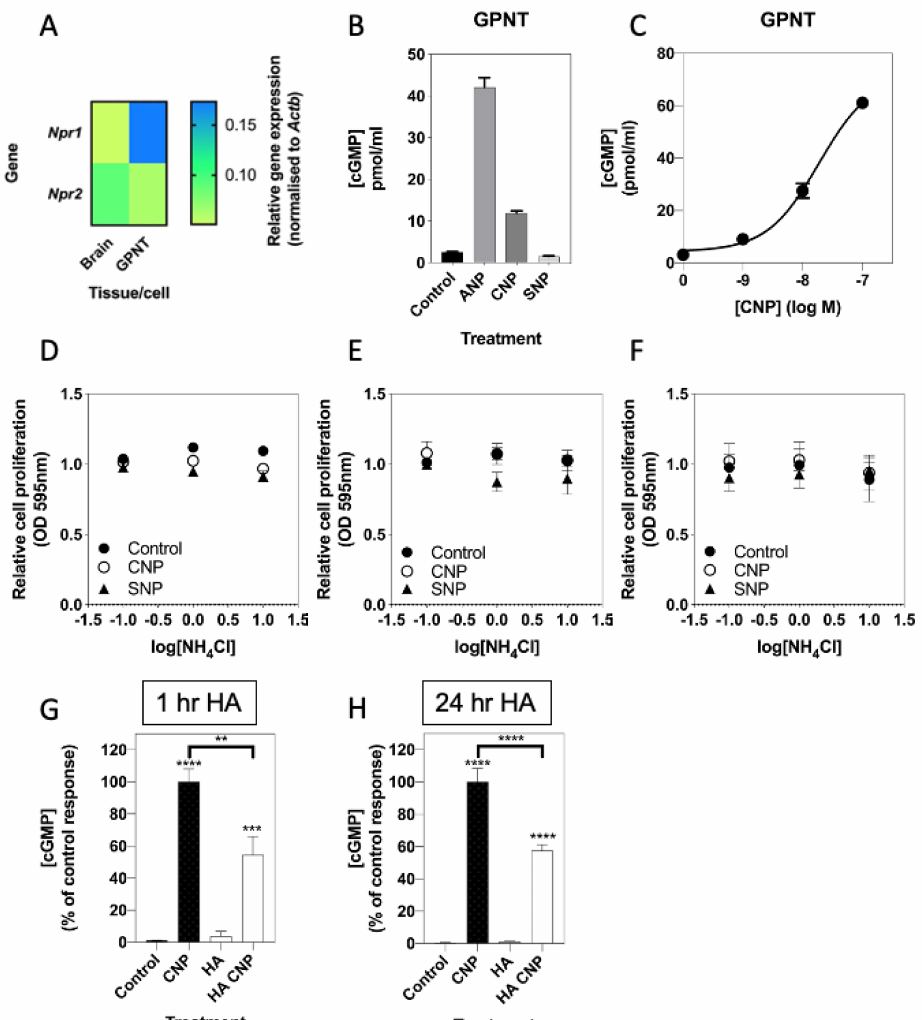
Figure 8. Effects of hyperammonaemia on the natriuretic peptide system in rat GPNT brain endothelial cells. ( A ) Multiplex RT-qPCR was performed on RNA extracted from rat brain tissue or GPNT cells. The data shown are mean relative gene expression, normalized to Actb , of 2 individual RNA extractions. ( B ) Total cGMP accumulation in GPNT cells treated with 0 or 100 nM ANP, CNP or 1 mM SNP for 1 h in physiological saline solution containing 1 mM IBMX, before assay. Data shown are means ± SEM of triplicate treatments. ( C ) Concentration-dependent effects of CNP on cGMP accumulation in C6 cells. Cells were treated with the indicated concentrations of CNP in PSS containing 1 mM IBMX for 1 h. Data shown are means ± SEM pooled from three independent experiments, each performed in triplicate. ( D – F ) Effects of hyperammonaemia and CNP on cell proliferation in GPNT cells. GPNT cells were treated with the indicated concentrations of NH 4 Cl in the absence or presence of 100 nM CNP or 1 nM SNP for ( D ) 24 h, ( E ) 48 h or ( F ) 72 h, before being fixed in 4% ( w / v ) paraformaldehyde and stained for crystal violet assay. The data shown are means ± SEM pooled from 3 independent experiments, each performed with 8 replicates. ( G , H ) Effects of hyperammonaemia on CNP-stimulated cGMP accumulation in GPNT cells. Cells were initially treated in media containing 1% ( v / v ) FCS and 0 or 10 mM NH 4 Cl (HA) for either ( G ) 1 h or ( H ) 24 h, prior to subsequent stimulation with 100 nM CNP in the presence of 1 mM IBMX for 1 h. The data shown are means ± SEM of five to seven independent stimulations, expressed as the percentage of the control response to CNP; ** p < 0.01, *** p < 0.001, **** p < 0.0001, significantly different from untreated (control), or from the control CNP response to CNP